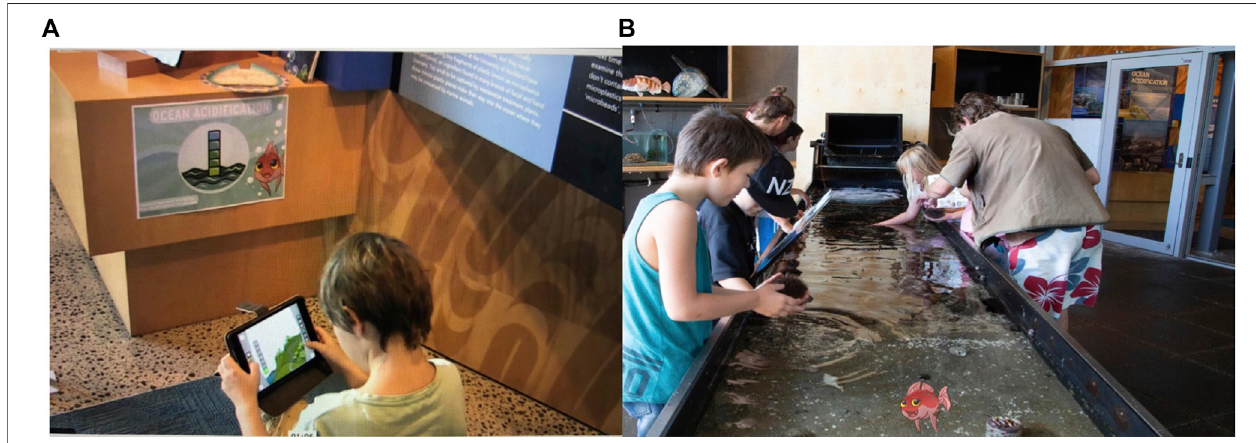
FIGURE 8 | (A) student learner engaging with an app-based augmented reality (AR) experience on ocean acidi fi cation and links to climate change; (B) touch tank activity engaging haptic and aesthetic experiences within the XR continuum (source: Aguayo and Eames,